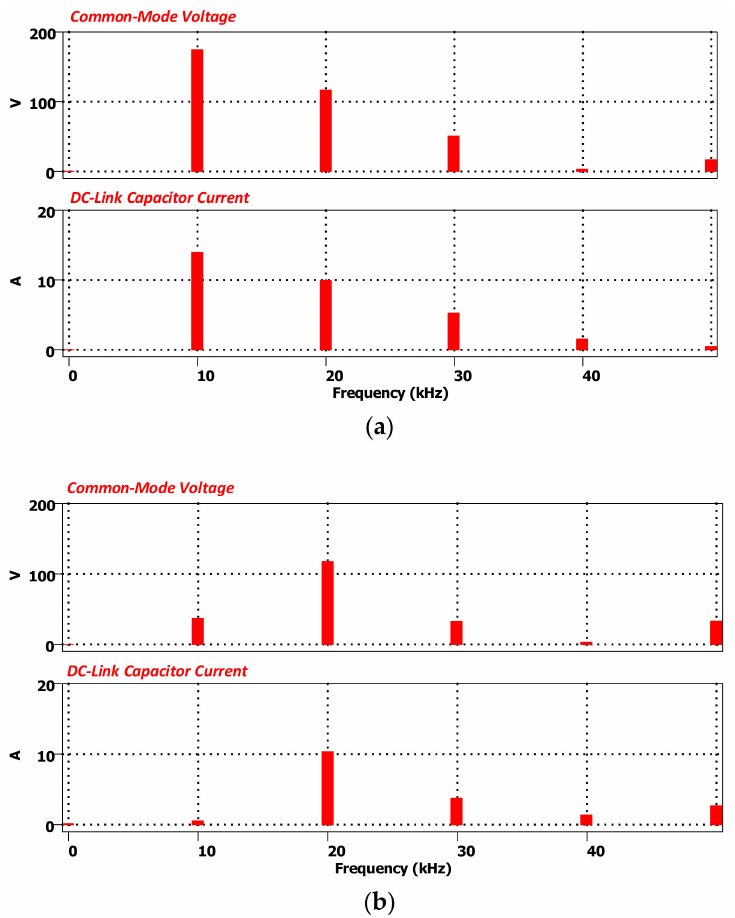
Figure 9. Simulation results. Frequency spectrum (FFT) of the common-mode voltage and DC-link ripple current: ( a ) Conventional method; ( b ) proposed